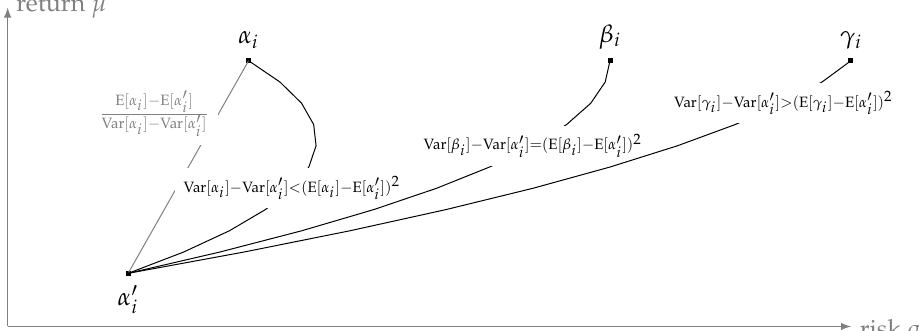
(cid:48) (cid:48) ) , ( β ) and ( γ ) in the µ - σ i , α i , α i i i